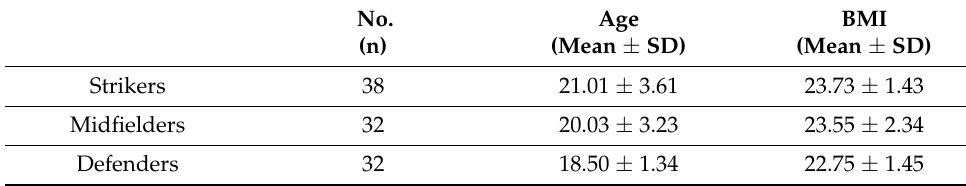
Table 1. Participants’ demographics (number, age, BMI) are reported for each